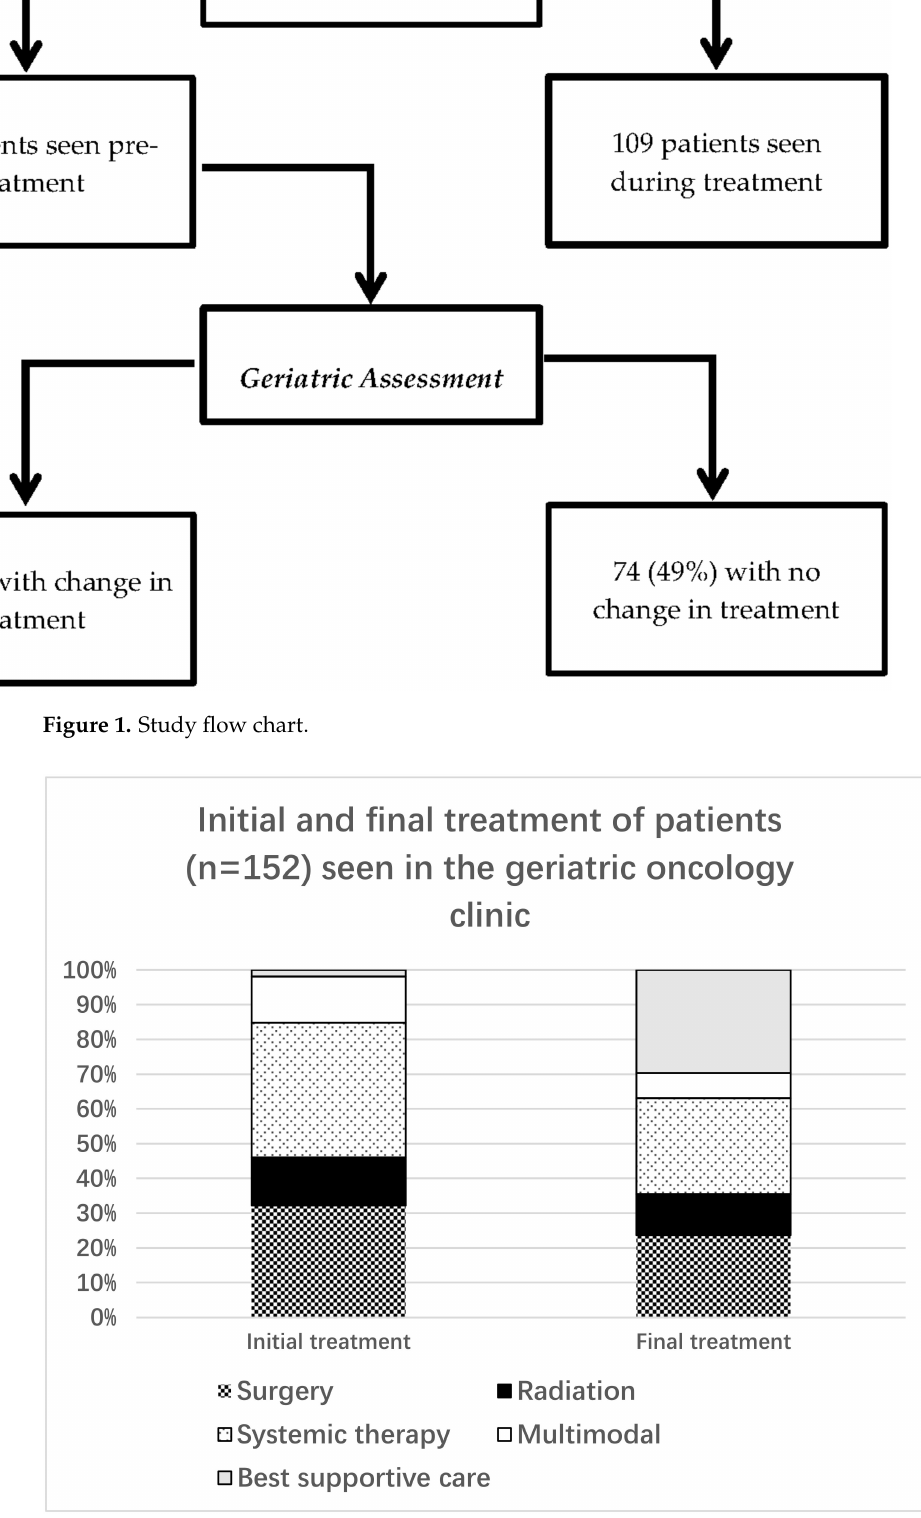
Figure 2. Initial and final treatments for patients included in the